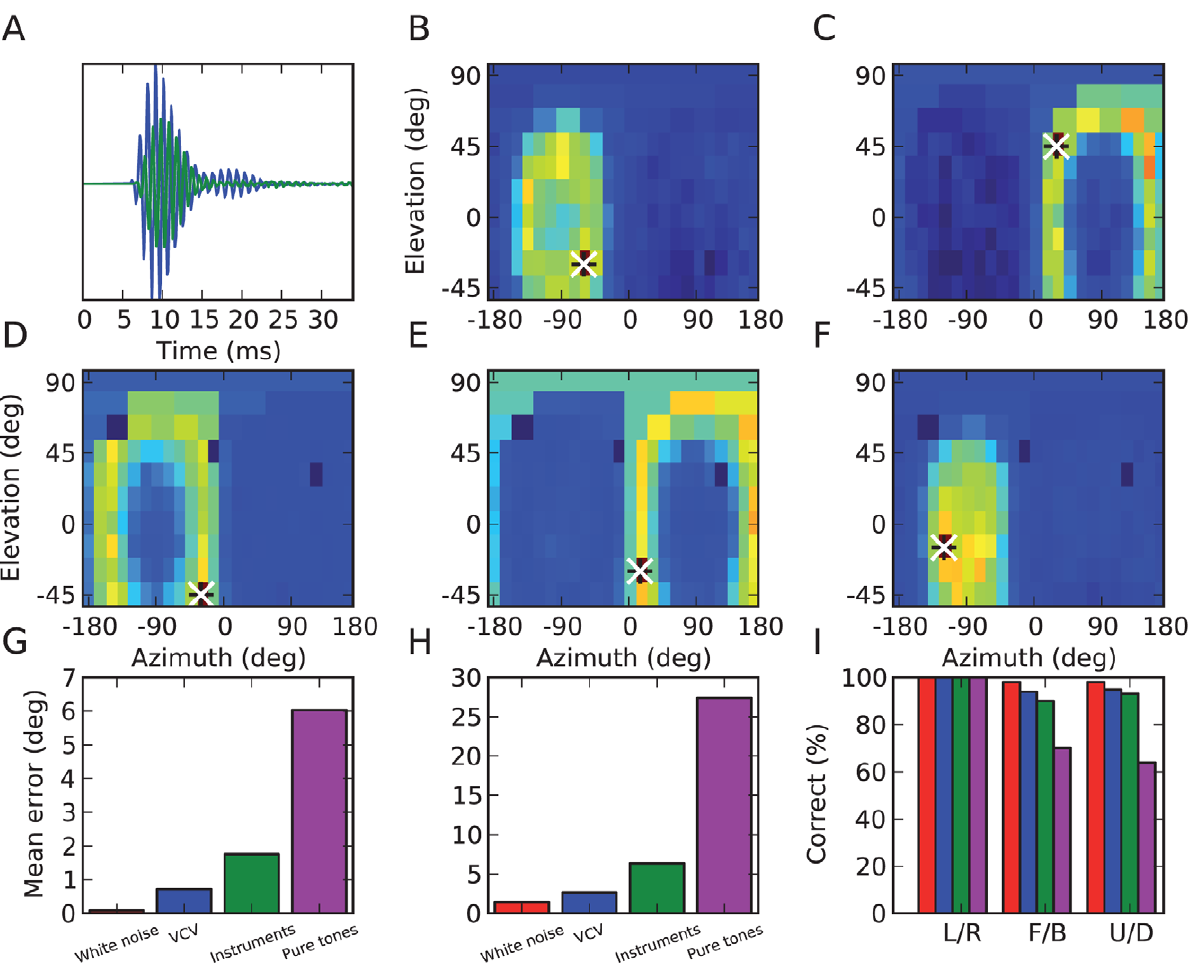
Figure 6. Estimation results in the ideal model. (A) Left (blue) and right (green) head-related impulse responses (HRIR) for a particular location passed through a gammatone filter. (B, C) Activation of all location-specific neural assemblies for two particular source locations, represented as a function of their assigned location. The black + shows the sound location and the white x shows the model estimate (maximally activated assembly). (D–F) Spatial receptive fields of three neural assemblies, i.e., total activation as a function of source location. (G) Mean error in azimuth estimates for white noise (red), vowel-consonant-vowel (blue), musical instruments (green) and pure tones (magenta). Front/back confusions do not contribute to azimuth errors in this panel. (H) Mean error in elevation estimates. (I) Categorization performance discriminating left and right (L/R), front and back (F/ B) and up and down (U/D).